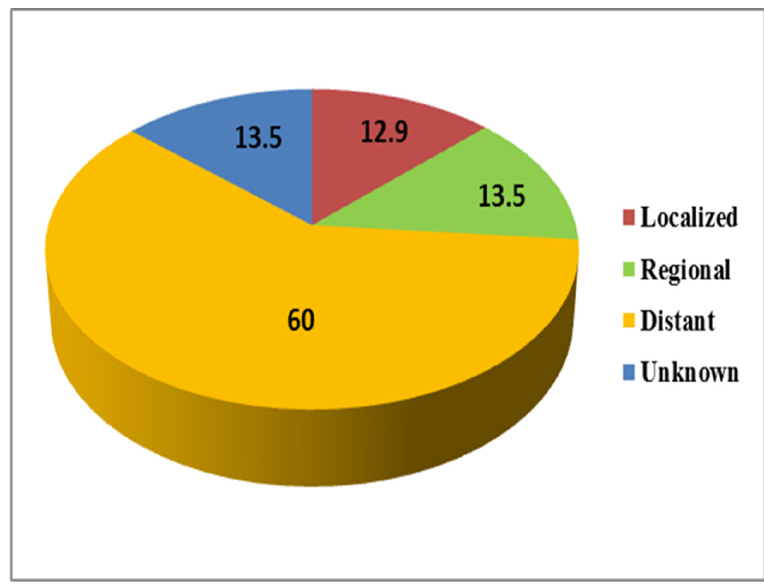
Figure 8. Overall percentage stage distribution of lung cancer in males during 2006 to 2016. The overall percentage of stage distribution of lung cancer from 2006 to 2016 among females was also investigated (Figure 8). Lung cancer was most often diagnosed at the distant stage (56.7%), followed by the localized (16.5%) and unknown stages (15.6%). The lowest percentage of lung cancer was diagnosed at the regional stage (11.2) (Figure 9).